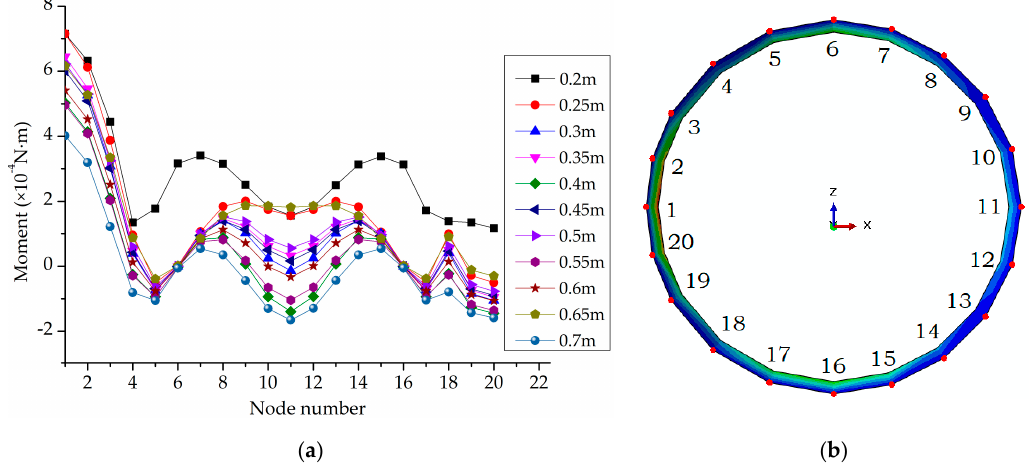
Figure 9. Base moment of tower model. ( a ) Base moment versus node number, ( b ) Node numbers at tower base.